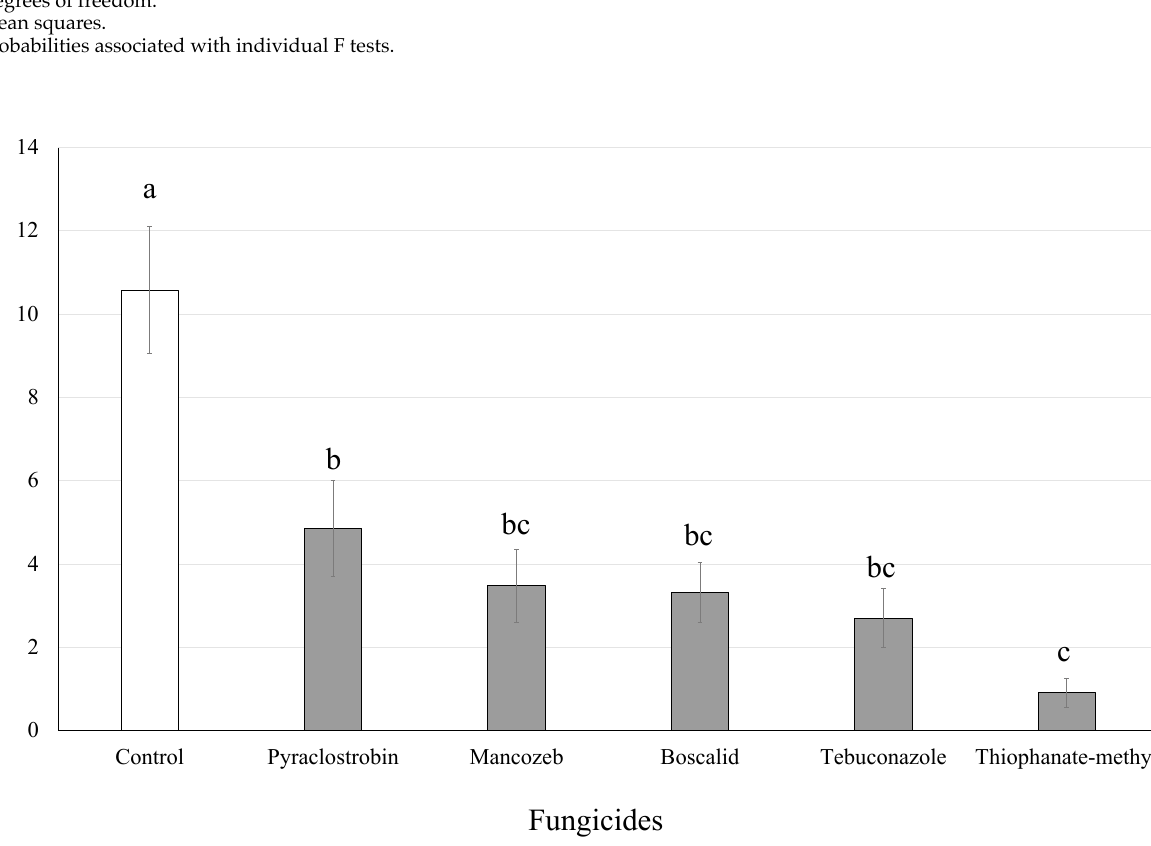
Figure 1. Mean lesion lengths (cm) caused by four Botryosphaeriaceae spp. on pruning wounds of almonds cv. Ferragnes, 5 months after pruning and fungicide application. Mean lesion lengths are based on 48 replicates per fungicide (three rep - licates per each of the four fungi and two inoculation times, and the experiment was conducted twice). Means followed by the same letter are not significantly different ( P > 0.05). Bars represent the standard errors of the